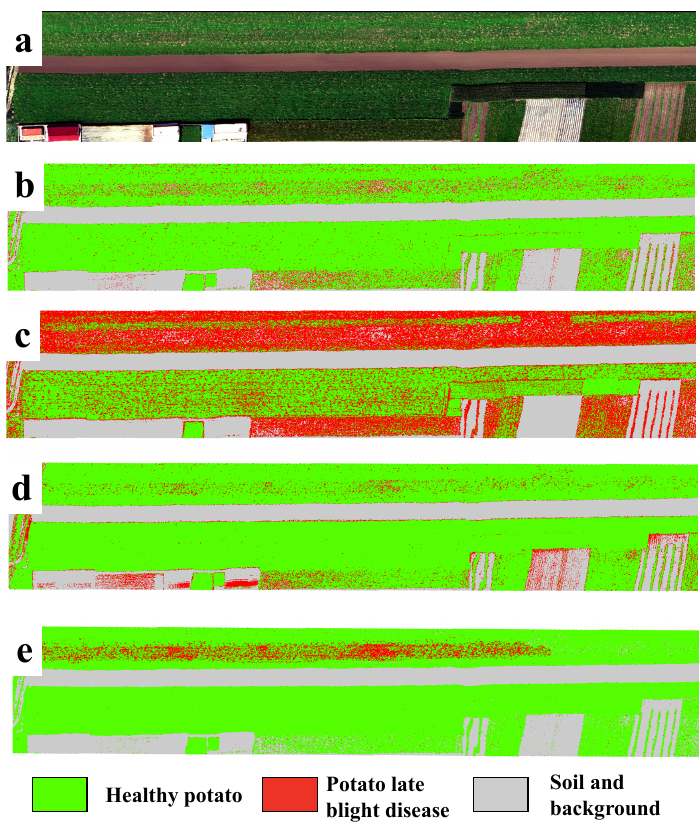
Figure 5. A comparison of the classification maps for the independent testing dataset from four models. ( a ) RGB composition map of the raw data, ( b – e ) Classification maps of SVM, RF, 3D-CNN and the proposed CropdocNet